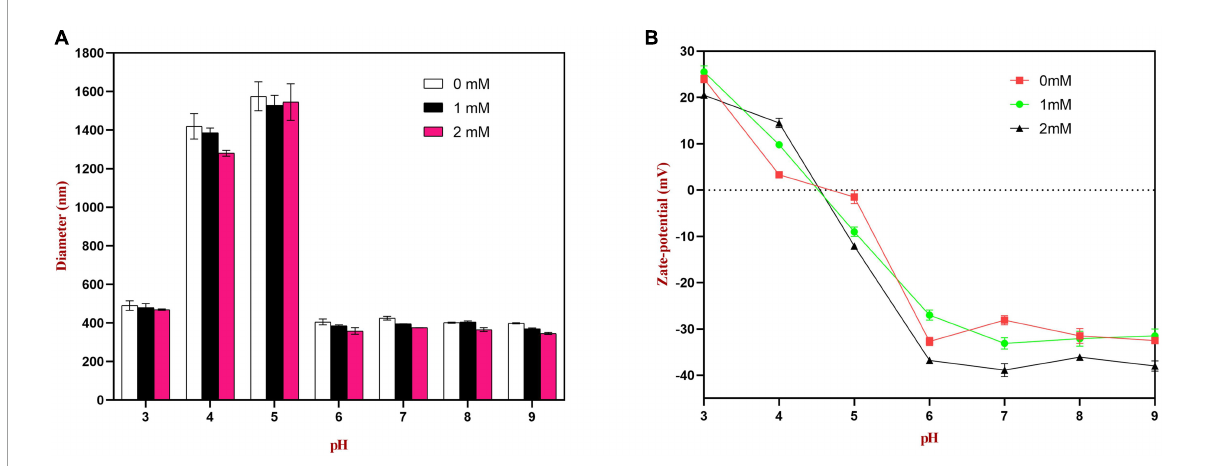
FIGURE7 Effects of pH on the particle size (A) and zeta potential (B) of WP or WP-HES complex stabilized